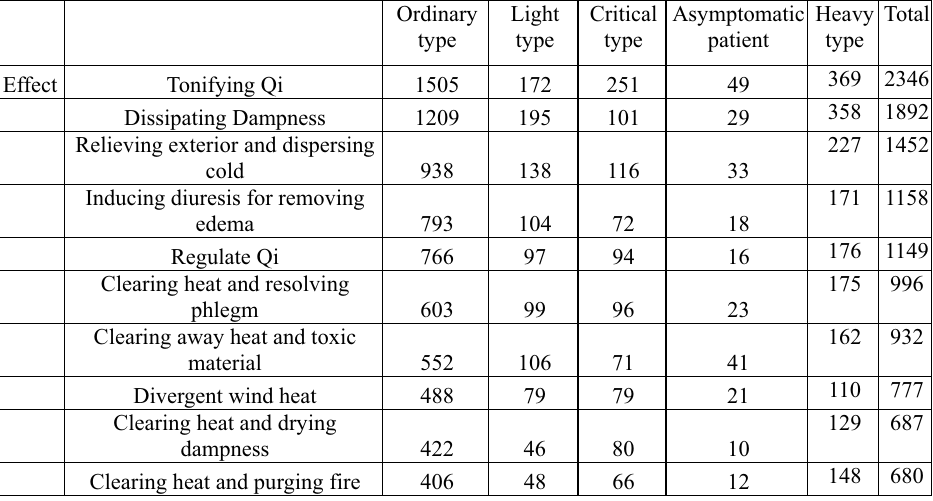
Table 2. Frequency distribution of drug efficacy in covid-19